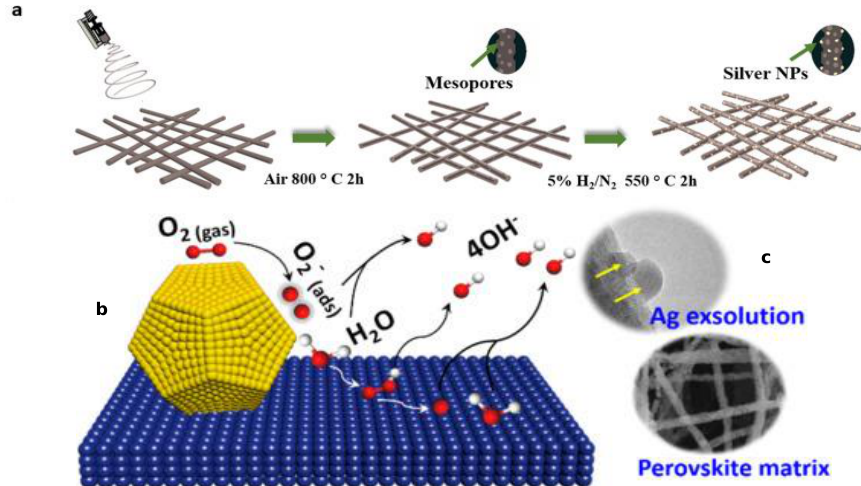
Figure 6. ( a ) Synthesis steps for the obtention of Ag-PBMO 5 electrocatalyst; ( b ) proposed scheme for ORR at the electrocatalyst surface; c) HRTEM images of exsolved Ag 2 O nanoparticles bonded to the perovskite surface and FESEM images of PBAMO 3 nanofibers. Reprinted with permission from Zhang, Y.Q.; Tao, H.B.; Liu, J.; Sun, Y.F.; Chen, J.; Hua, B.; Thundat, T.; Luo, J.L. A rational design for